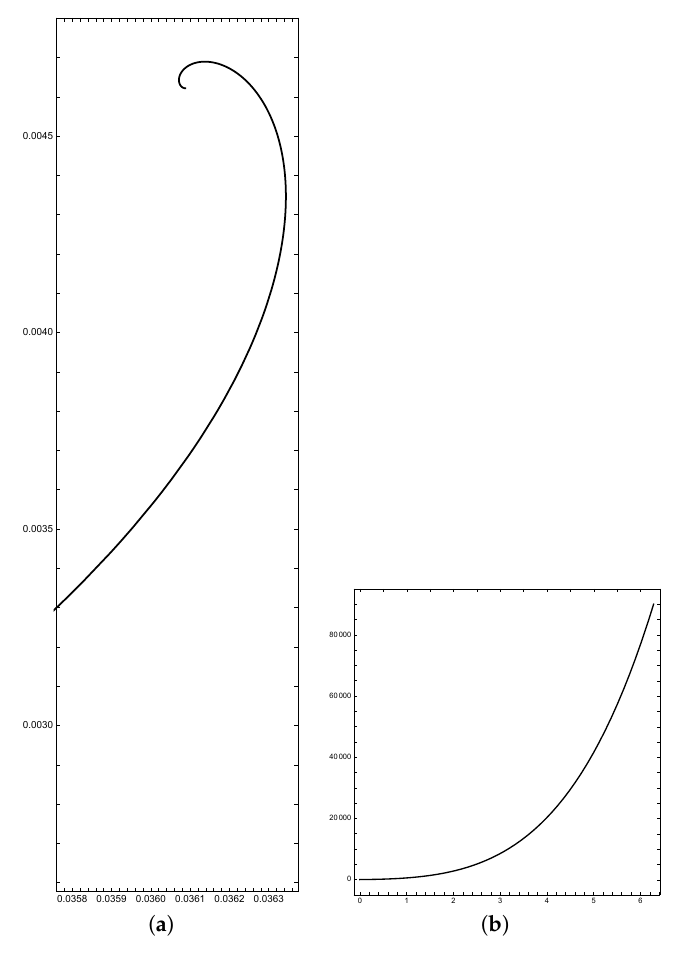
Figure 7. ( a ) Curve with ρ ( θ ) = U ( 5,1.5, θ ) , 0 ≤ θ ≤ 2 π , ( b )